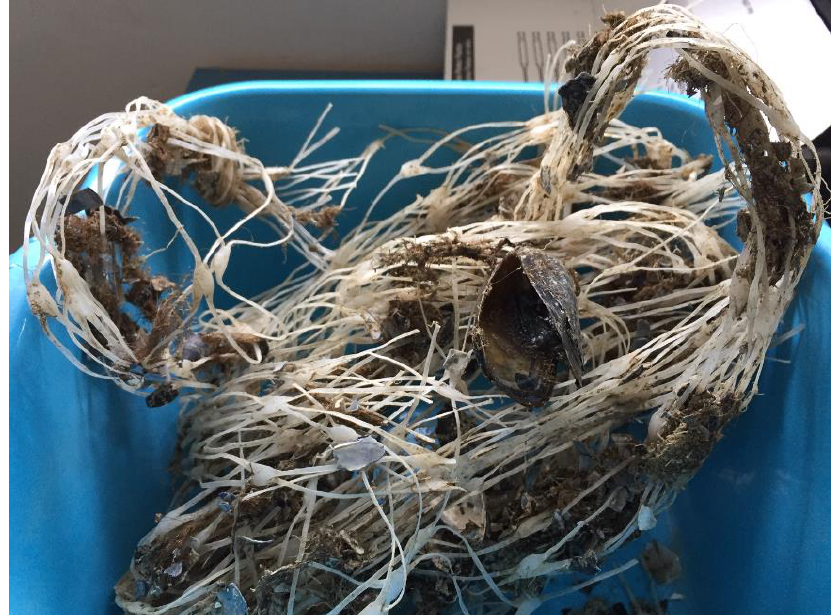
Figure 2. Mussel nets as recovered from the sea.